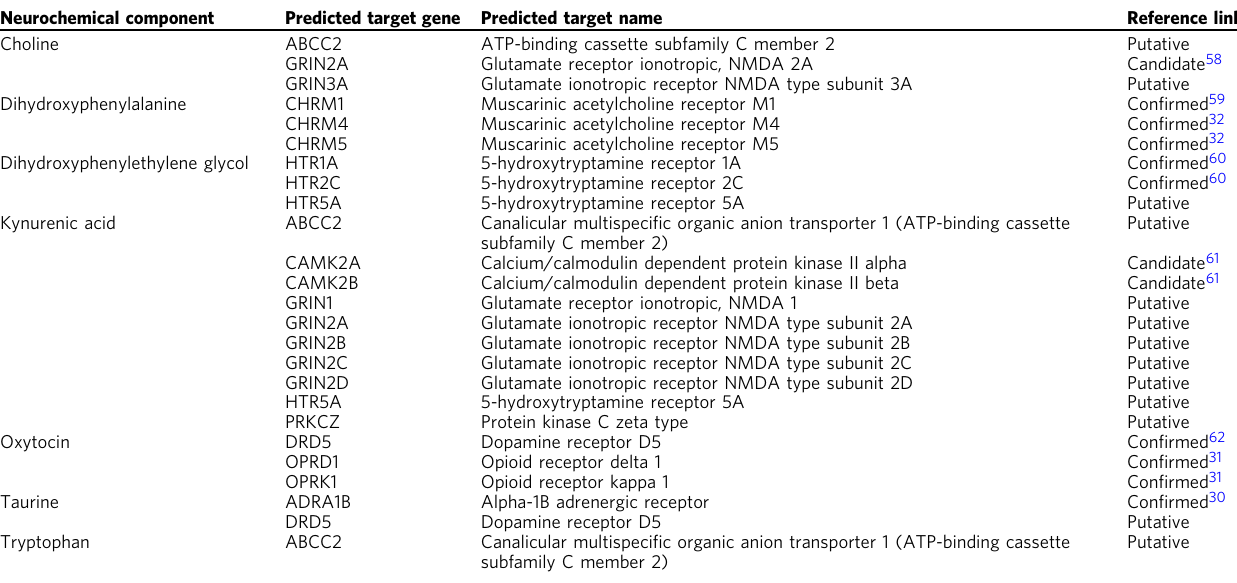
The table contains links between neurochemical components and protein target predictions with a 100% hit rate — i.e., every compound active at that neurotransmitter were predicted to interact with thesetargets.Thelinks identi fi ed from bioactivecompoundsfromthe in silicotarget predictionprotocol areshown alongwithanyliteratureevidence.Putativelinks andpre-identi fi ed candidate links can be the focus of future neuro-biochemical